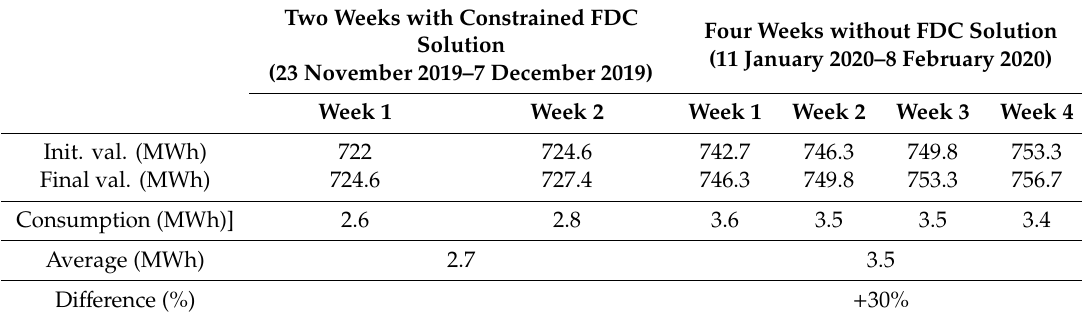
Table 1. Total energy consumption (MWh) of the drinking water facility (DWF).